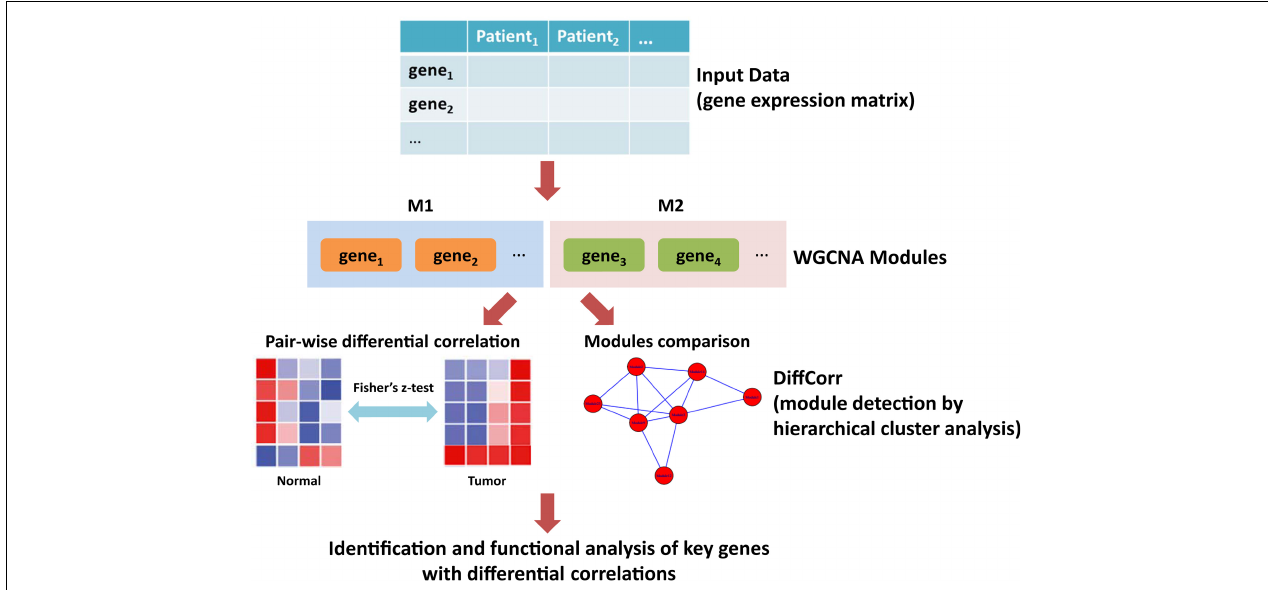
FIGURE 1 | The workflow of this study. First, the gene expression matrix of LUAD patients was obtained. Second, the WGCNA network was constructed and genes were clustered into modules. Third, differential correlations between genes were calculated and significant differences between tumor and adjacent normal tissues were identified using DiffCorr. Finally, functional analysis of key genes with differential